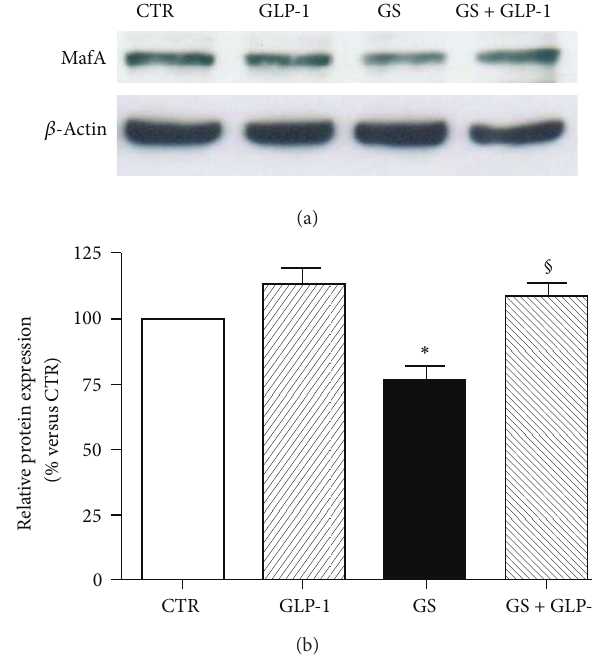
Figure3:GLP-1doesnotaffectGSRexpressioninHIT-T15cellscul- tured with AGEs. (a) Representative western blot of three different experiments. (b) Quantification of densitometries of western blot bands. Data were expressed as mean ± SE of fold induction relative to 𝛽 -actin ( 𝑛 = 3 ). ∗ 𝑃 < 0.05 versus CTR.